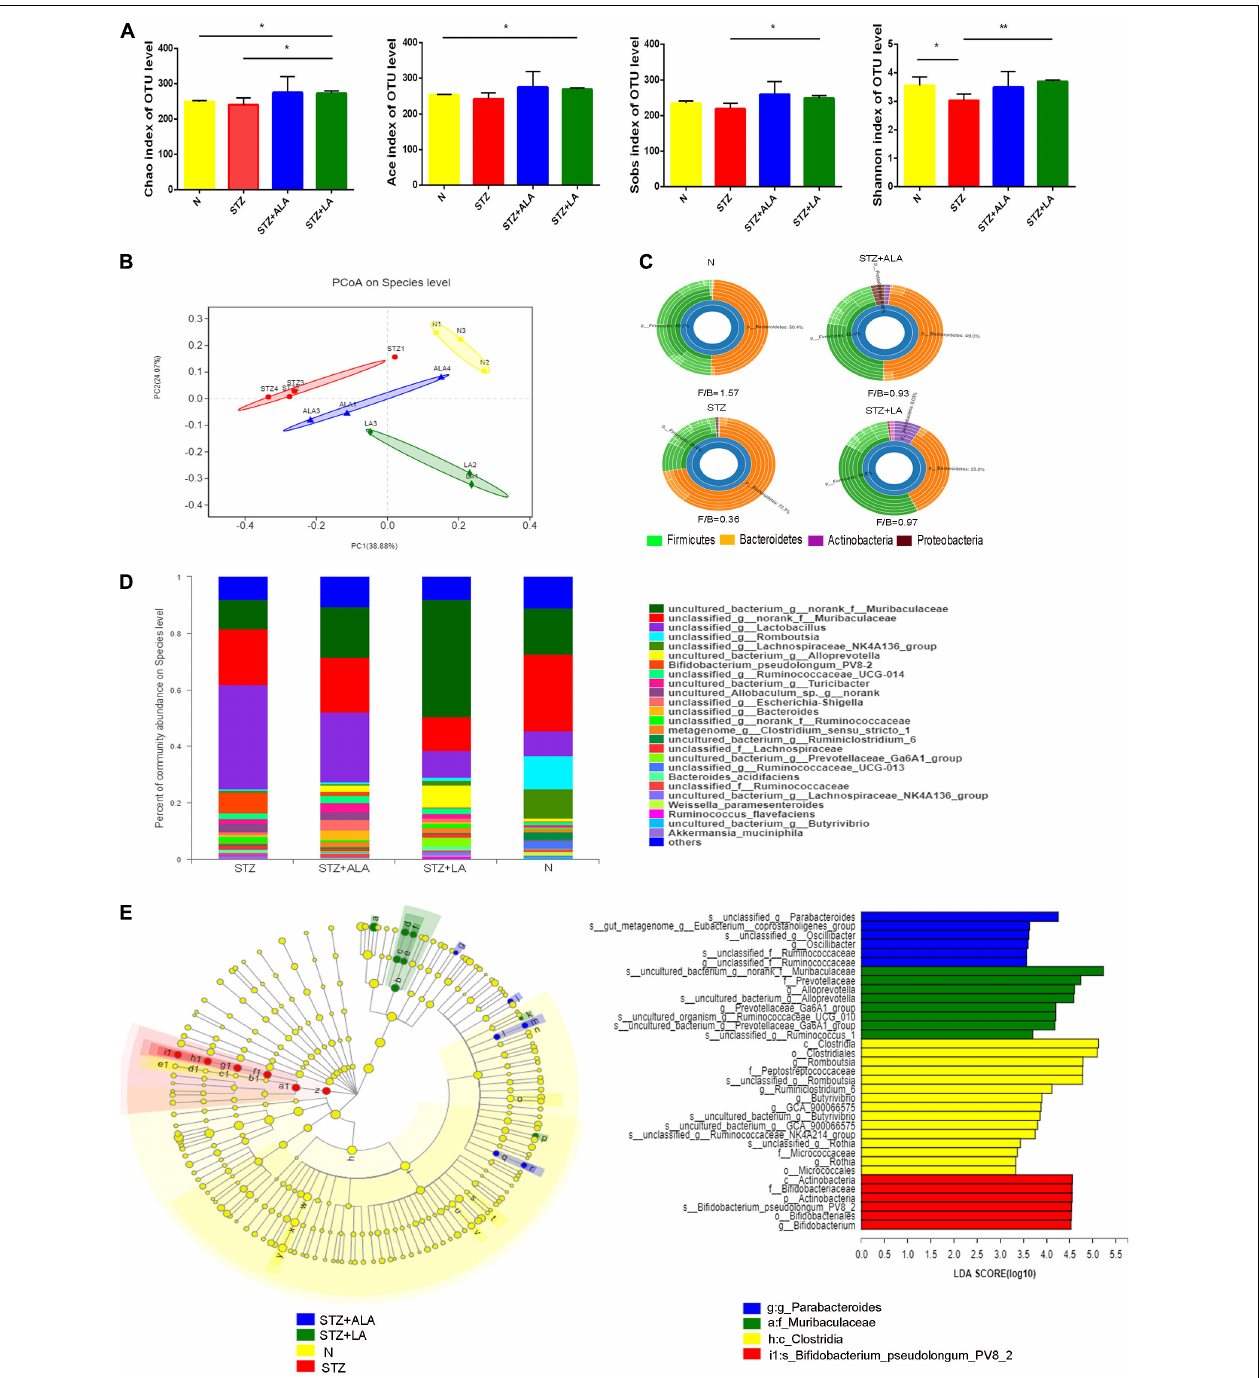
FIGURE 5 | ALA and LA alter gut microbiota composition. Fecal microbiota composition in normal control, the STZ group, the STZ + ALA group, and the STZ + LA group were analyzed using 16S rDNA sequencing ( n = 3–4). (A) Analysis of animals’ feces for the α -diversity of microbiota. Data are expressed as mean ± SEM ( n = 3–4). * p ≤ 0.05, ** p ≤ 0.01. (B) Principal co-ordinates analysis (PCoA) based on unweighted UniFrac distance as a measure of β diversity across samples. Each point represents 1 sample. Samples in the same group are labeled the same color. (C) Relative abundance of dominant bacteria at the phylum level. (D) Relative abundance of dominant bacteria at the genus level. (E) LEfSe analysis of enriched bacterial taxa in gut microbiota. LEfSe-derived taxonomic cladogram and the LDA score of enriched bacterial taxa (LDA > 3.5 of LEfSe) were presented. Significantly enriched bacterial taxa in the fecal samples from different groups are indicated by different